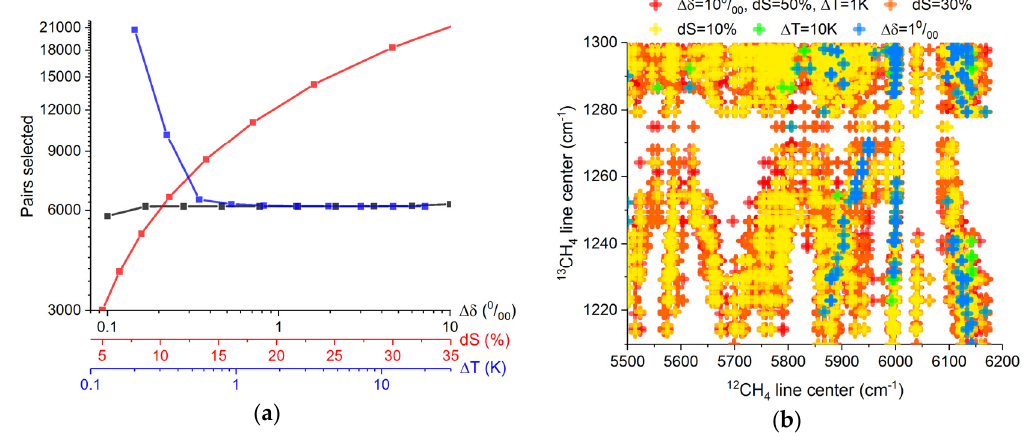
Figure 5. ( a ) Number of selected isotopic line pairs as a function of filtering criteria stringency. Δ T , Δ δ and dS are varied, successively, with the remaining parameters fixed at their baseline values of Δ T = 10 K, Δ δ = 1 ‰ and dS = 10%. ( b ) Selected line pair positions in wavenumber space. Least stringent pairs are in red, successive colours are gradually more stringent by adjusting one parameter at a time. Blue corresponds to the baseline set.